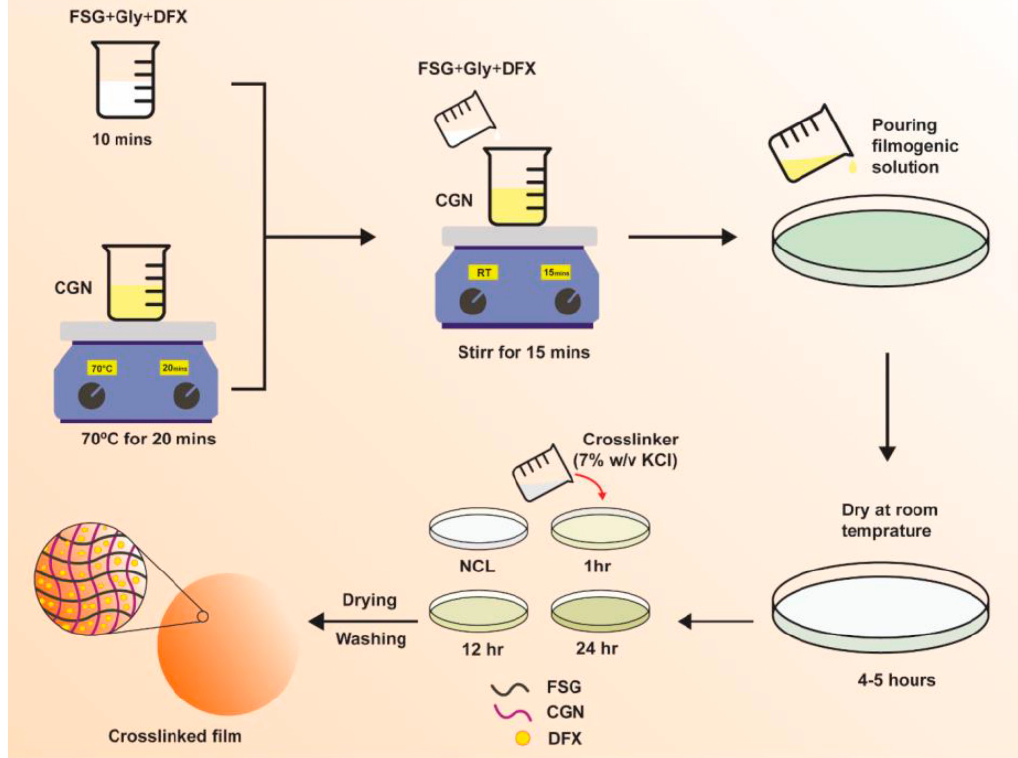
Figure 1. Schematics of DFX-loaded FSG/CGN biocomposite hydrogel film. Table 1. Composition of the non-crosslinked and crosslinked biocomposite hydrogel films. Samples